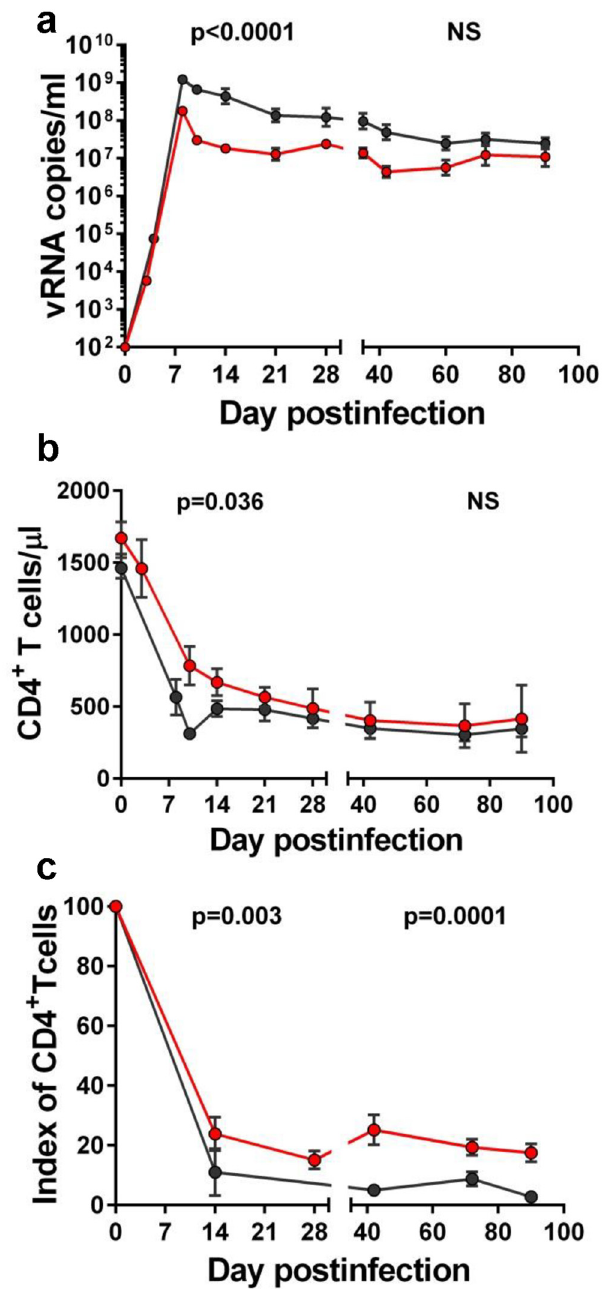
Fig 5. Rifaximin (RFX) + sulfasalazine (SFZ) therapy improves the natural history of SIVsab infection during acute and early chronic SIVsab infection of pigtailed macaques (PTMs). Levels of acute viral replication were significantly lower in SIVsab-infected PTMs receiving RFX+SFZ (red) compared to untreated controls (black) (a). While no significant impact of RFX+SFZ treatment could be observed in circulating CD4 + T cells (b), a less prominent depletion of mucosal CD4 + T cells could be observed in treated PTMs (c). The average values for each group and standard error of means are